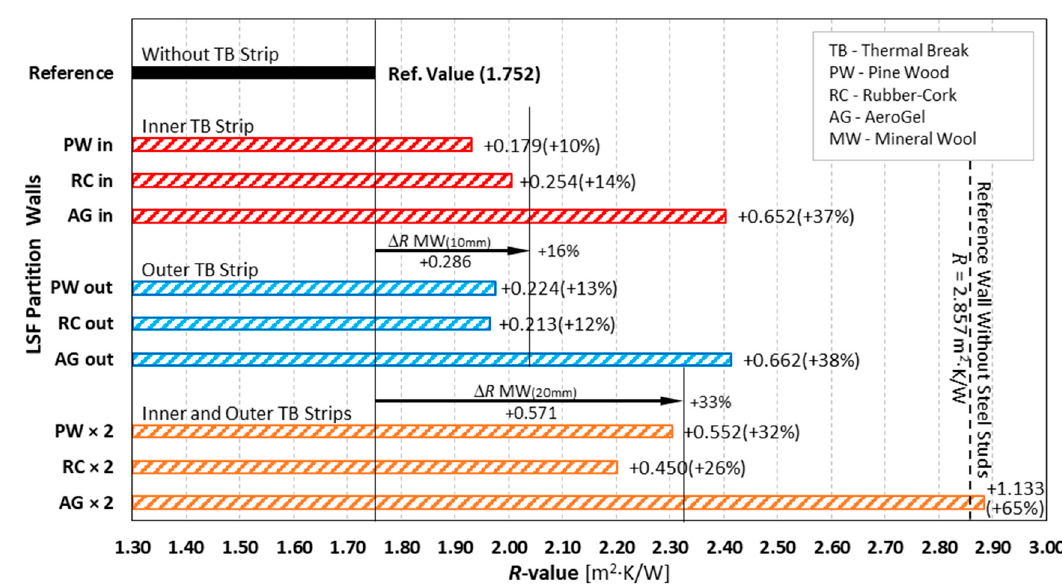
Figure 6. Measured conductive thermal resistances of LSF partition walls.